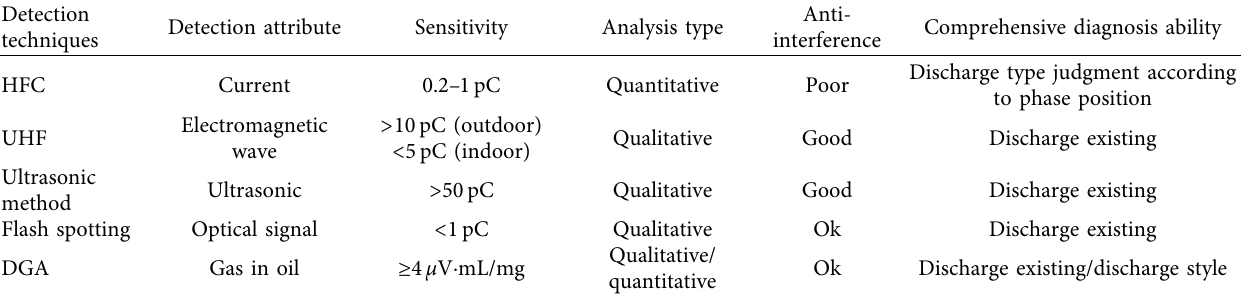
Table 1: Comparison of charge detection techniques of PD